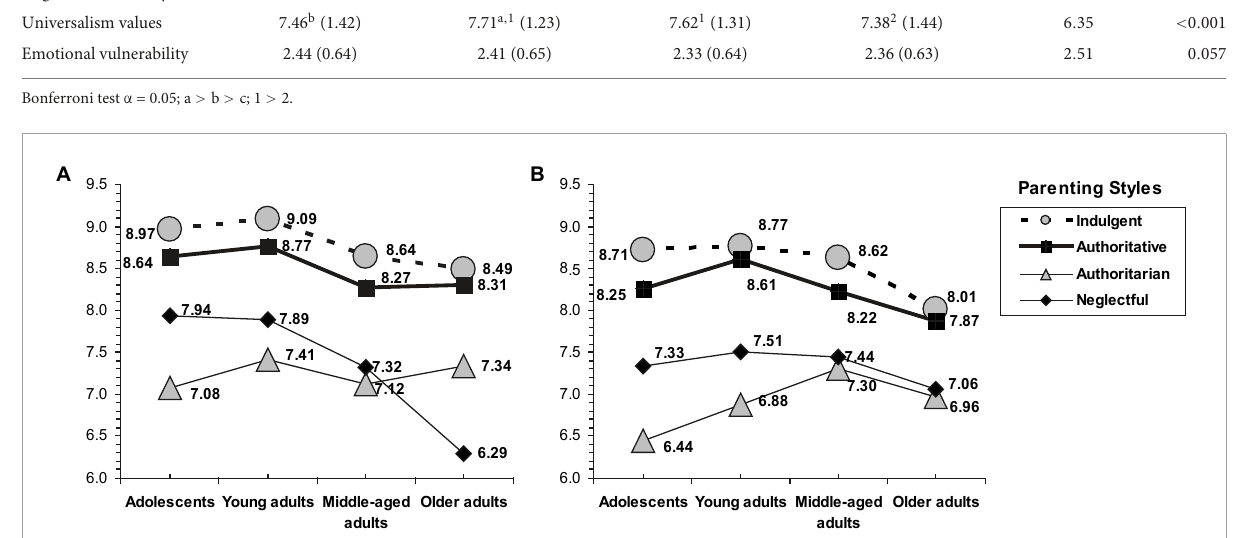
FIGURE1 Interaction of parenting styles by age group and sex on family self-concept. (A) Family self-concept (women). (B) Family self-concept (men).